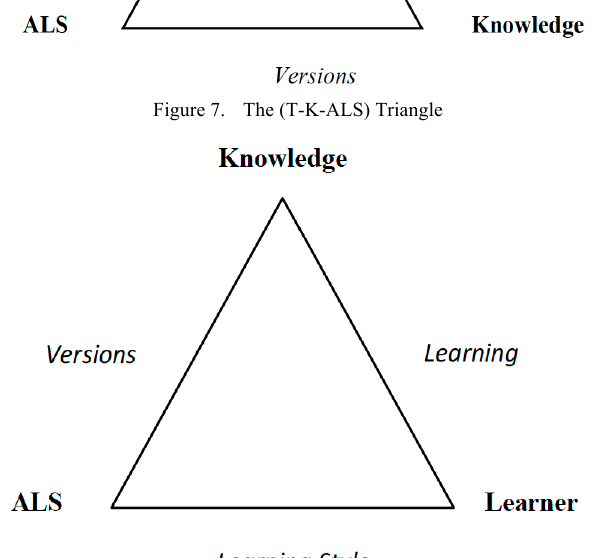
Figure 7. The (T-K-ALS) Triangle